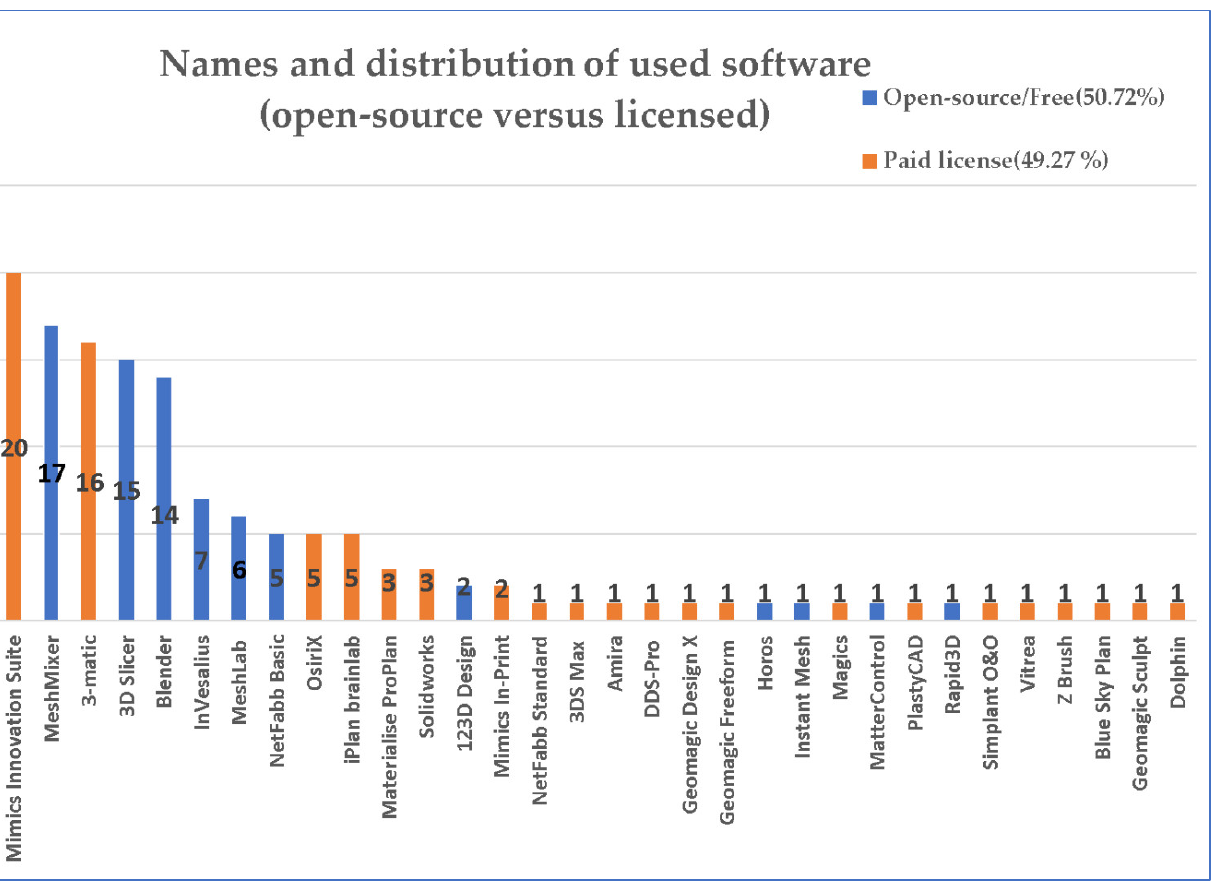
Figure 3. Graphical representation of the used software, number of mentions across the reviewed articles, and percentual usage distribution of free versus paid software.